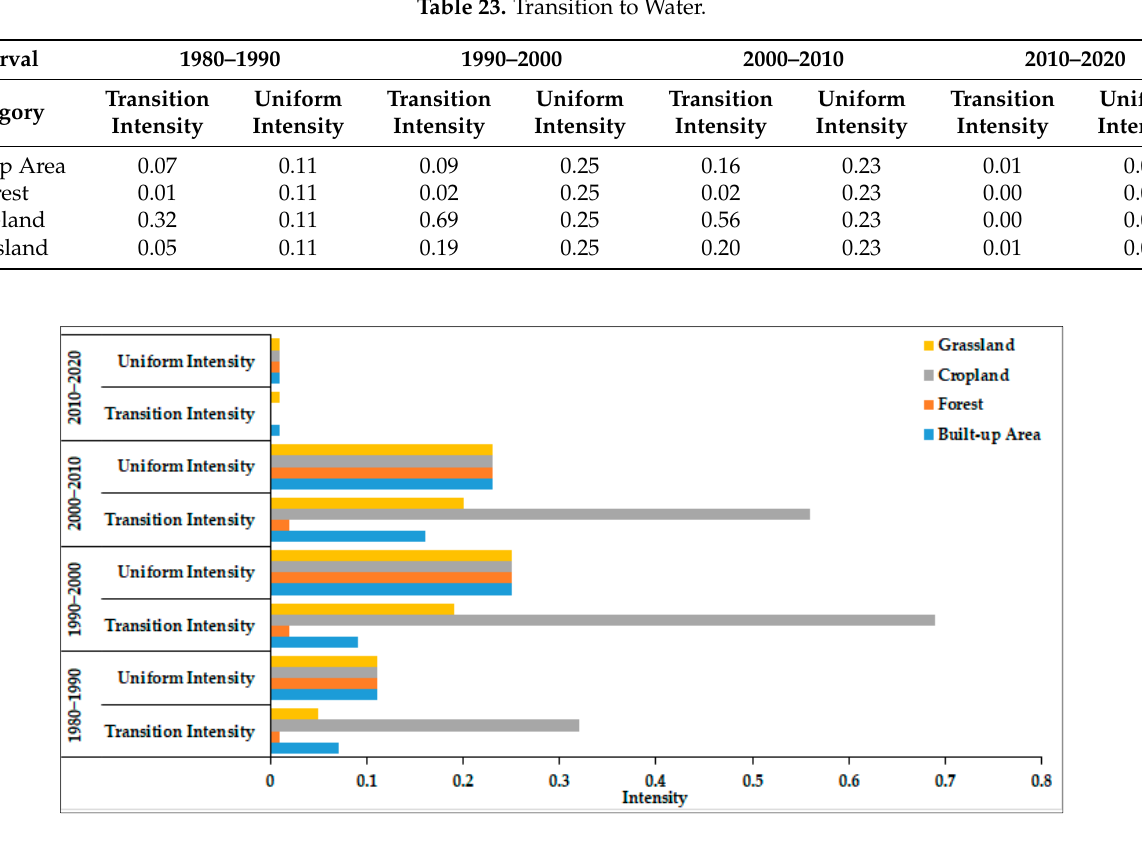
Figure 14. Transition to Water.